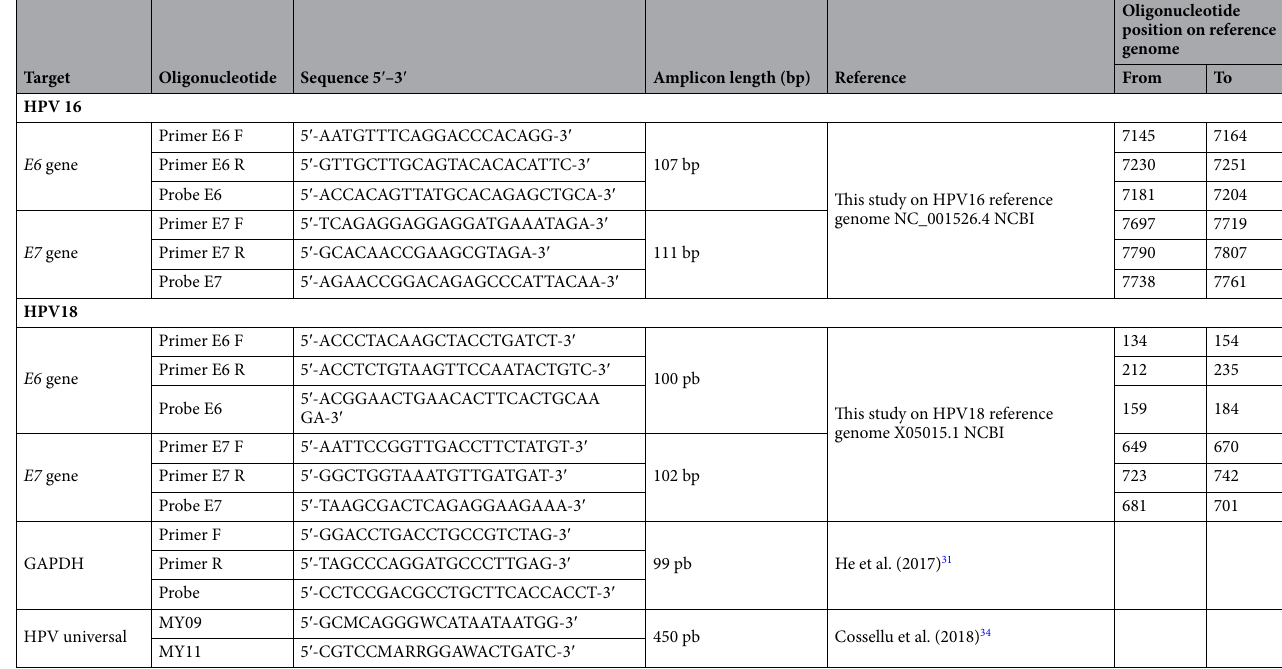
Table 1. Primers and probes used in